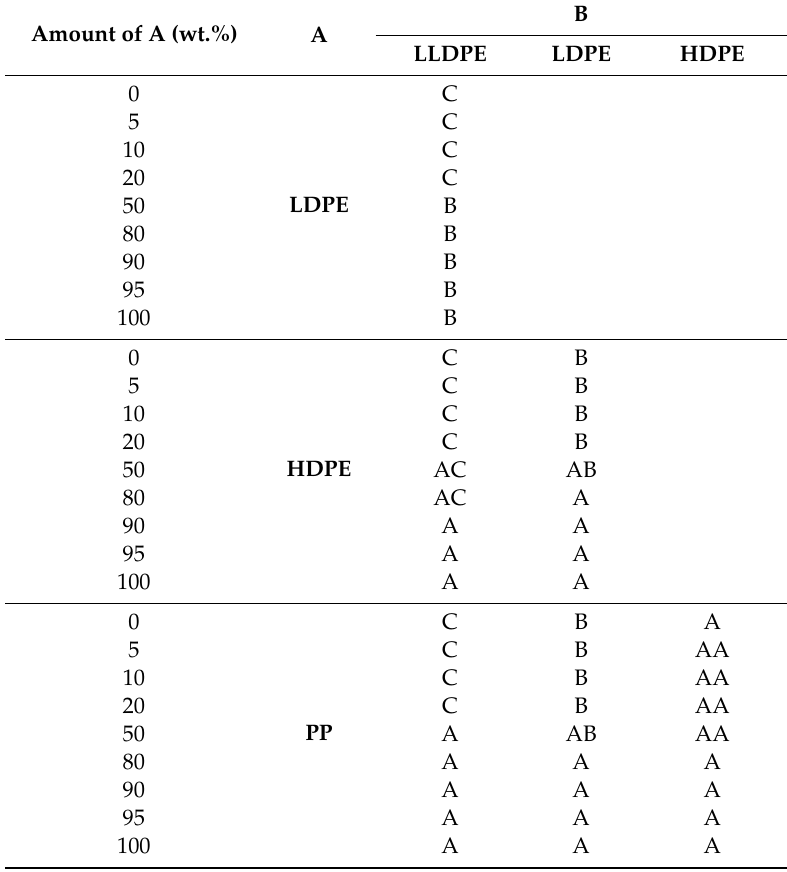
Table 5. Typical deformation curve for each blend, the letter of which corresponds to the deformation mechanisms described in Table